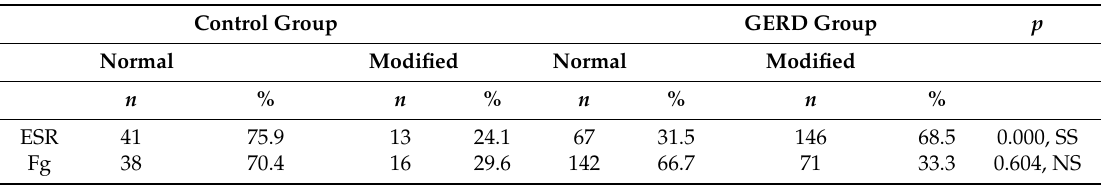
Table 2. Comparative study of ratios regarding patients with modified inflammatory parameters in the GERD group and the control group.